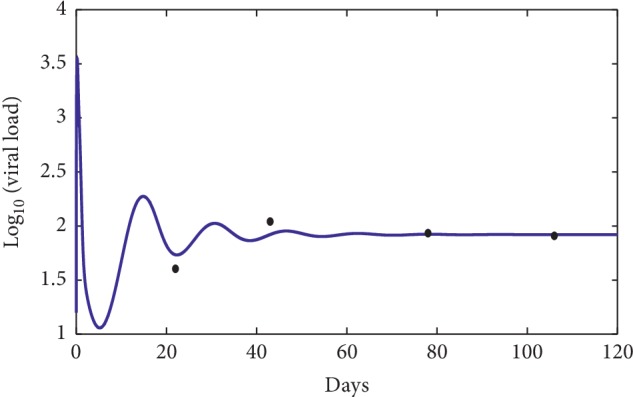
Comparison between the mathematical model (solid line) and the clinical data of the first patient [18] (dots). The used parameters for the model are λ=10, d1=0.0139, k1=0.05, d2=0.0495, k2=1.1, d3=0.5776, a=850, d4=0.6, q=0.5, g=1.2 × 10−3, h=0.1, p=0.0024, c=0.15, and b=0.5.